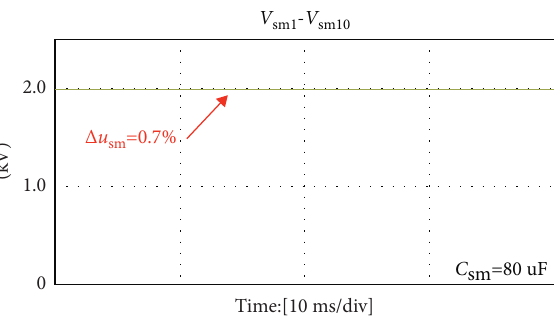
Figure 13: SM voltage waveform.